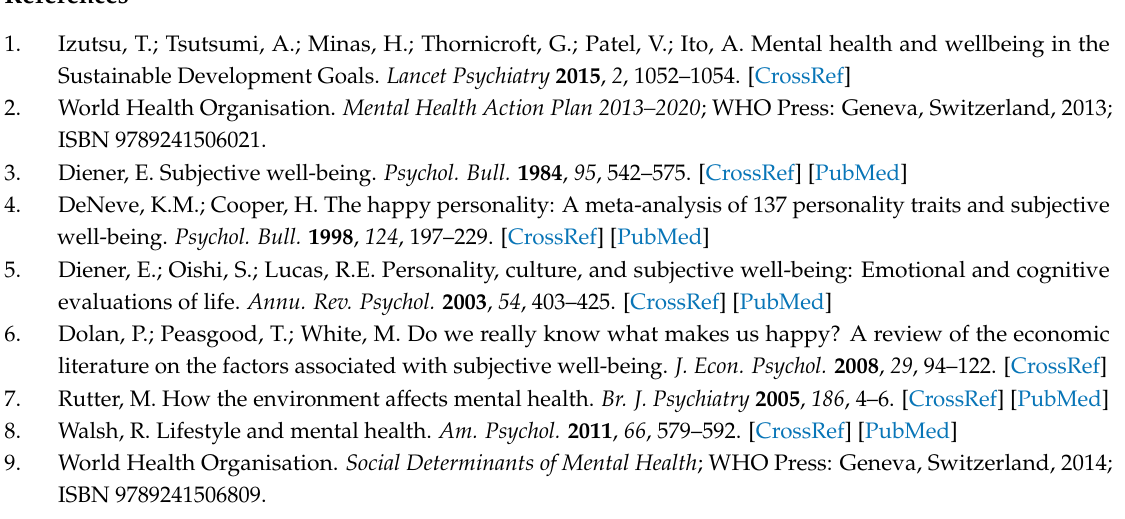
s1. Table S1: Descriptive data for all covariates; Table S2: Unstandardised conditional effects of social contact frequency on mental wellbeing at values of the moderators; Table S3: Binary logistic regression predicting the Odds Ratio (OR) of reporting